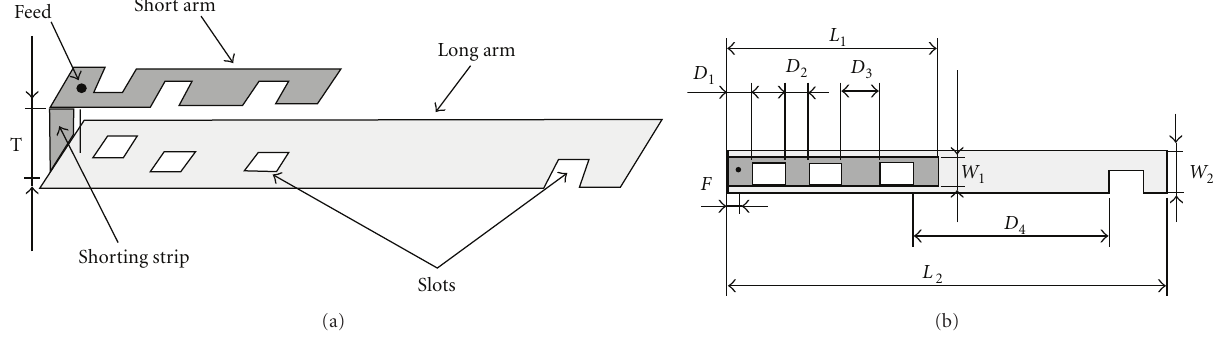
Figure 1: Geometry of the new wideband resonant antenna.